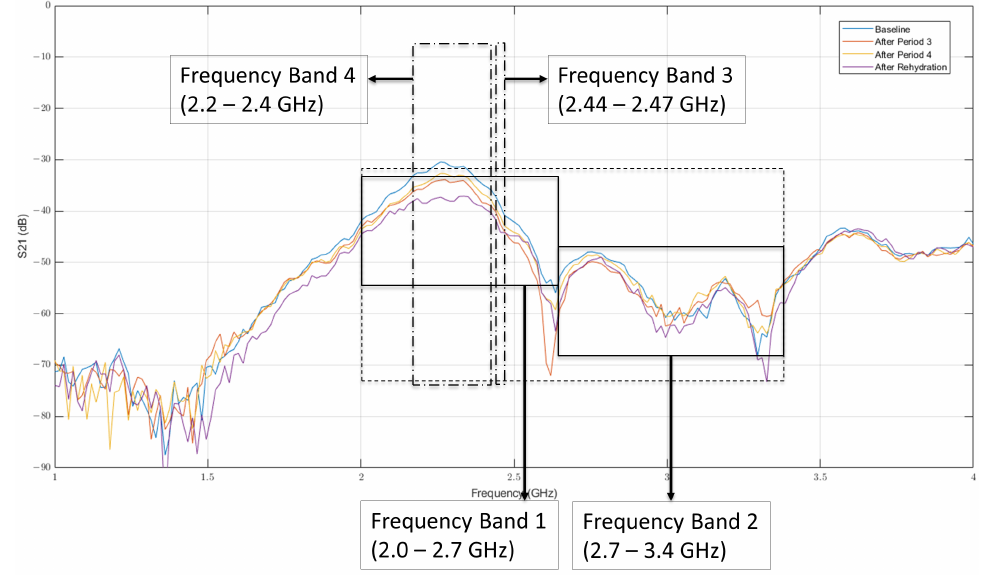
Figure 6. Sample plot of S21 magnitudes for one participant during different instances.